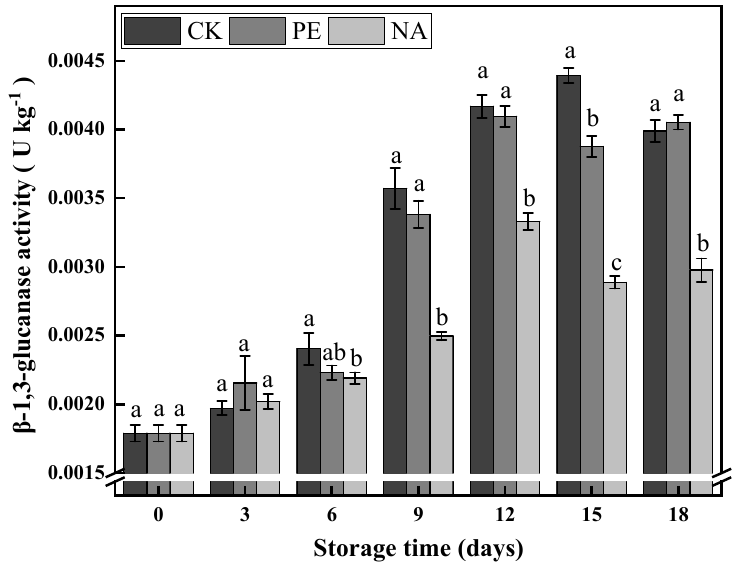
Figure 4. Effects of different types of packaging on β -1,3-glucanase activity in the elongation zone of postharvest F. velutipes stipes.